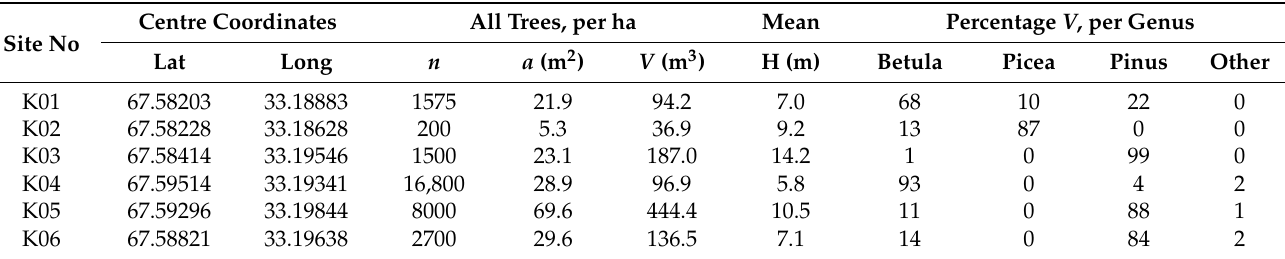
Table 2. Locations and calculated forest parameters of the field plots in the Khibiny (K) study area. * Site K18 was a recent burn site with very little regeneration, and not used in the analysis. ‘Per hectare’ values were calculated by extrapolation from the measured